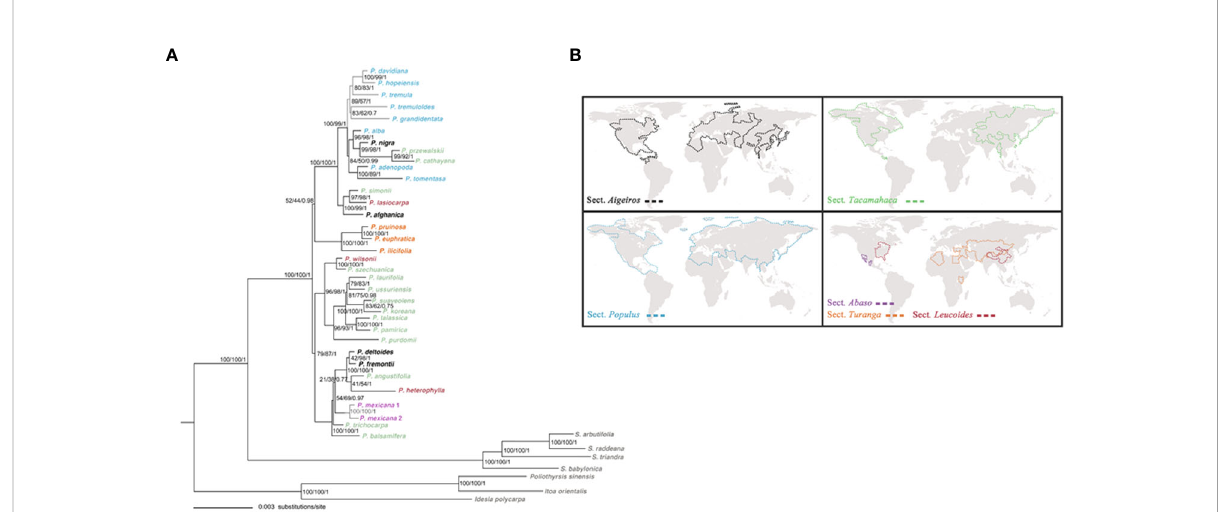
FIGURE 2 (A) The ML tree of Populus and outgroups based on combined 34 plastid fragments. Numbers above branches indicate bootstrap values for the MP and ML analyses, and Bayesian posterior probabilities, respectively. (B) The geographical distributions of six sections of genus Populus is modi fi ed from Wang et al.